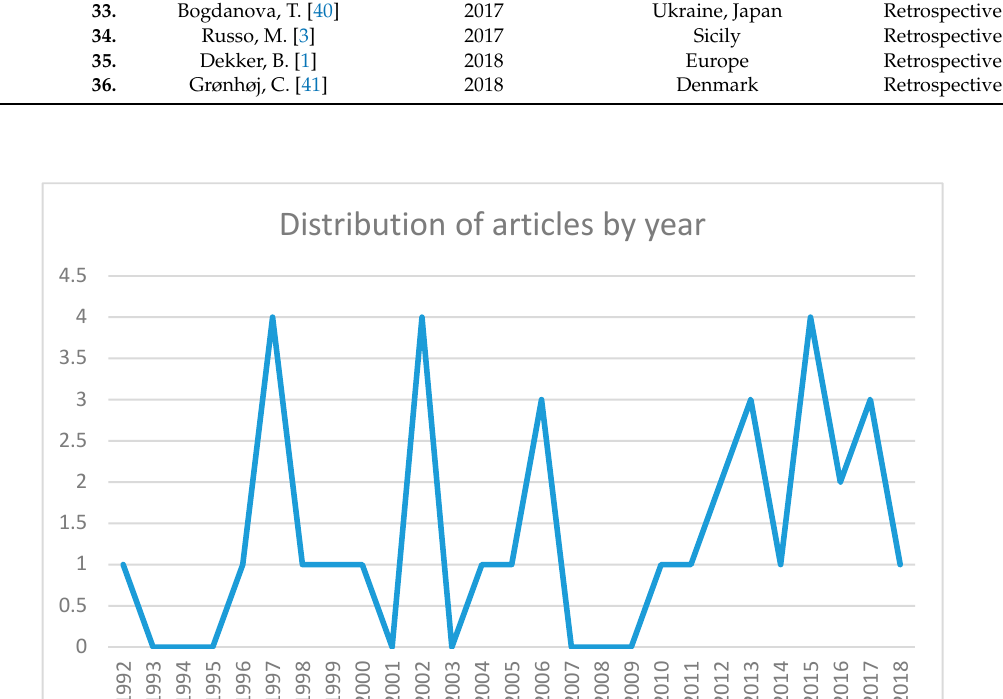
Figure 2. Graphical distribution of articles over time.